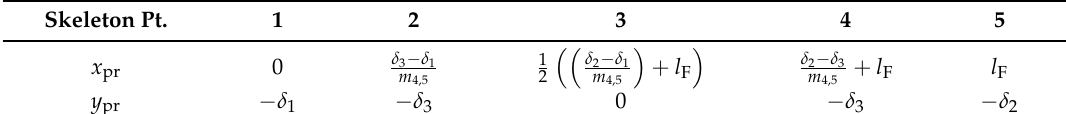
Table 3. Skeleton point coordinates.